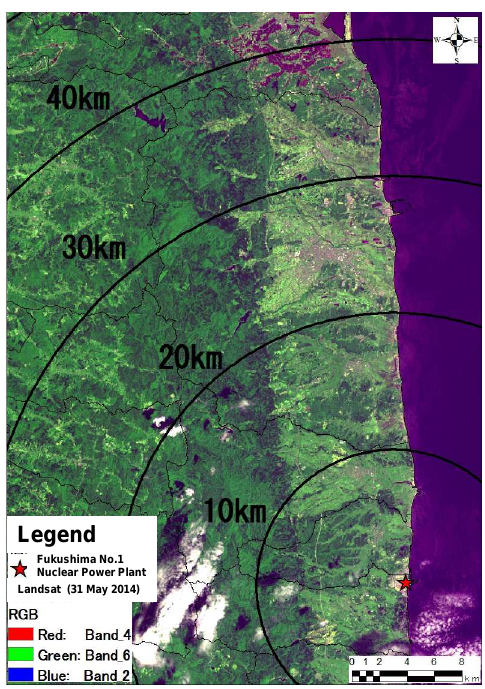
Figure 10. Natural Color Image using Landsat-8 OLI data (31 May 2014, RGB ： 4,6,2)